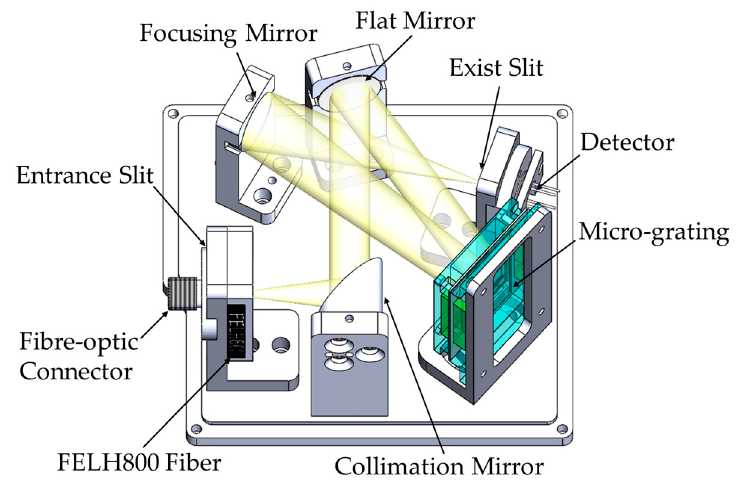
Figure 2. Drawing of the optical layout and assembly of the spectrometer.